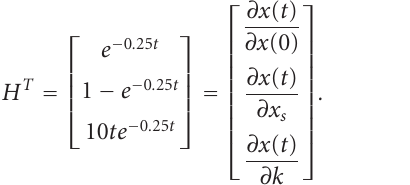
where H = H ( t ) = [ ∂x ( t ) /∂x (0), ∂x ( t ) /∂x s , ∂x ( t ) /∂k ] is the forward sensitivity vector and σ = [ δx (0), δx s , δk ] T . Clearly, (74) corresponds to an under-determined linear least squares problem, whose optimal solution is given by [7, chapter 5]